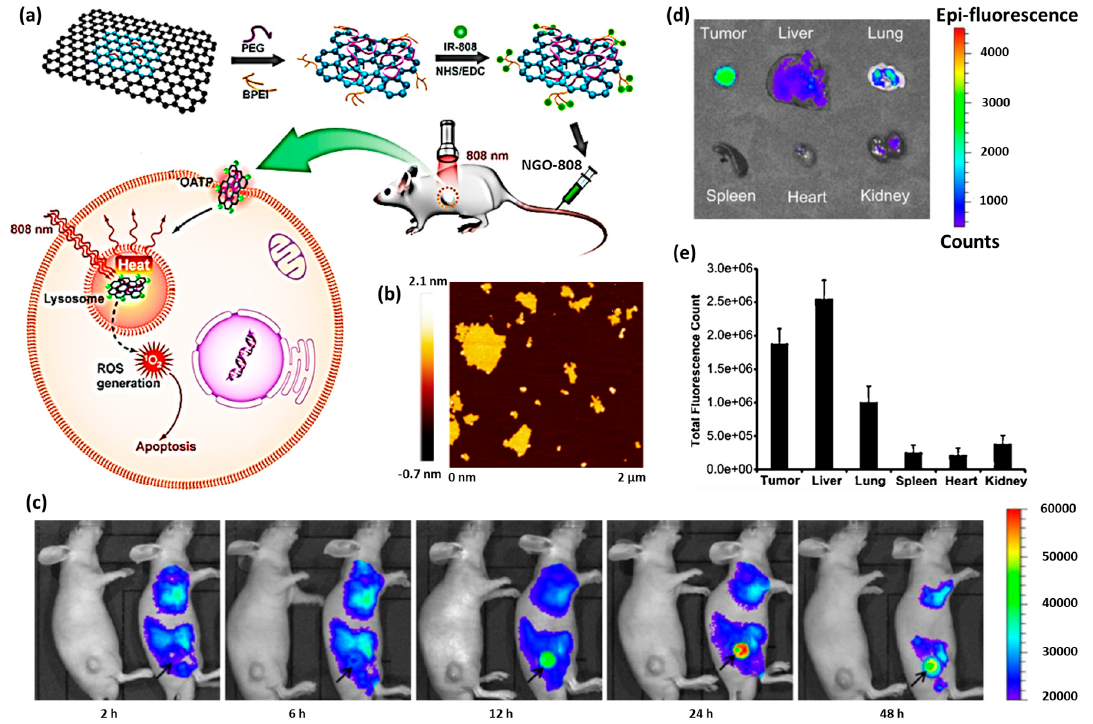
Figure 4. ( a ) A schematic diagram explaining the formation of tumor-targeted NGO-808, which was obtained by grafting NIR photodynamic photosensitizer (IR-808) onto the PEG- and BPEI dual- functionalized nanographene oxide (NGO). PDT / PTT combination therapy was achieved by the enhanced tumor accumulation through IR-808-mediated organic anion transporting polypeptide (OATP) transport under laser irradiation (808 nm). ( b ) AFM image of bare NGO nanosheets. Adapted with permission from [43]. ( c ) In vivo NIR fluorescence images of HeLa tumor-bearing nude mice after intravenous injection of saline (left mouse) or Cy 5.5 labeled Pluronic functionalized NGO (right mouse). The position of the tumor was indicated by a black arrow. ( d ) Ex vivo NIR fluorescence images of major organs and tumors of sacrificed mice showed a high fluorescence signal in tumor tissue, indicating a substantial accumulation of Pluronic coated NGO in the tumor. ( e ) Biodistribution profile of Pluronic functionalized NGO in major organs of mice at 48 h of post-injection ( n = 3). Adapted with permission from [99].